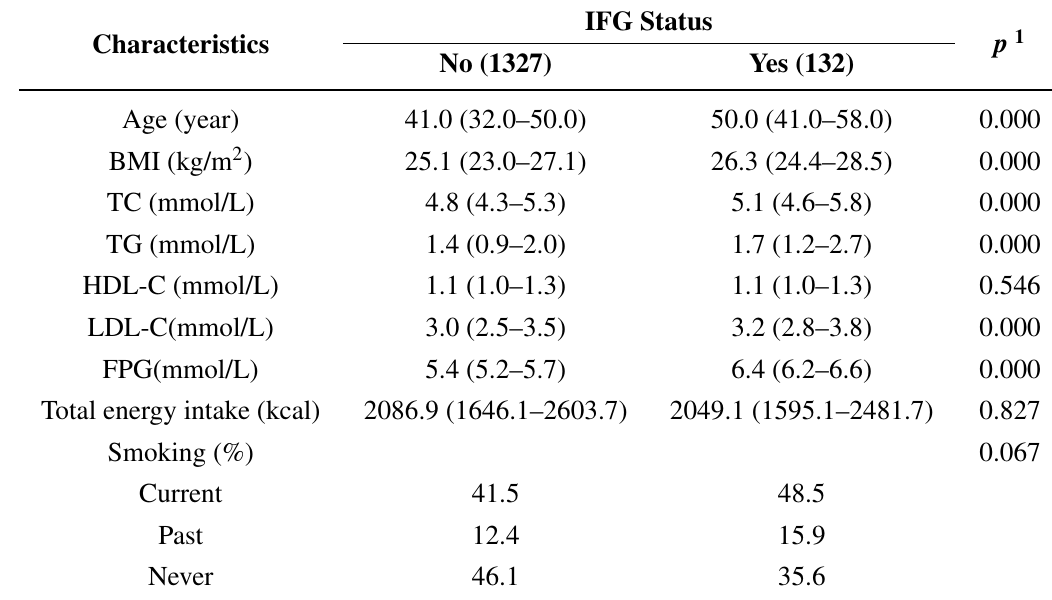
Table 1. General characteristics of study